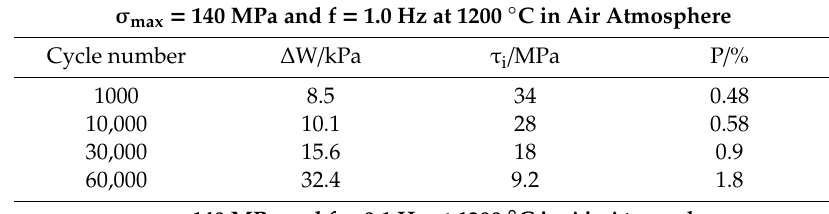
Table 6. Cycle-dependent damage evolution of 2D woven self-healing Hi-Nicalon TM SiC / [SiC-B 4 C] composite under σ max = 140 MPa at 1200 ◦ C in air and in steam